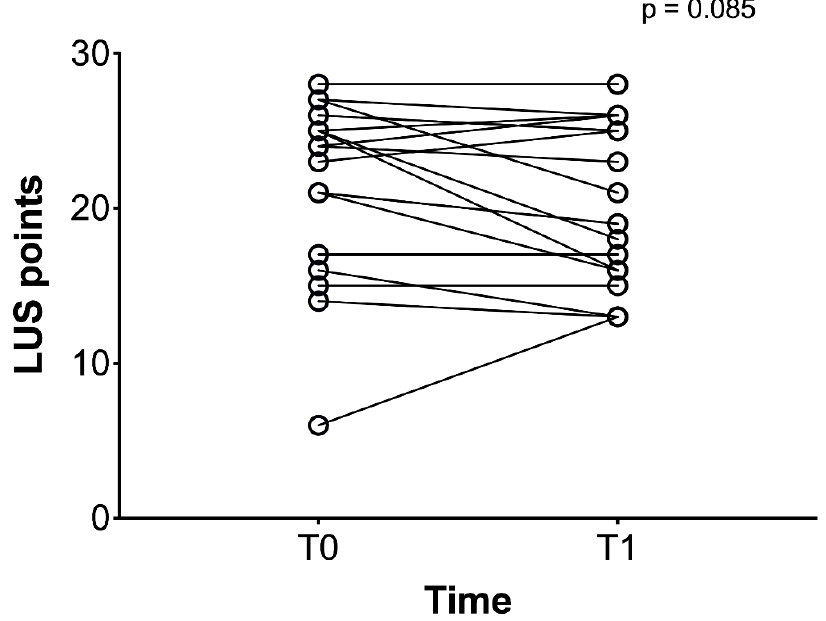
Figure 4. LUS score at baseline (T0) and after RPT (T1). In this figure all the twenty patients are represented as circles. The response of LUS to RPT is represented by a black line during the study time (from T0 to T1).